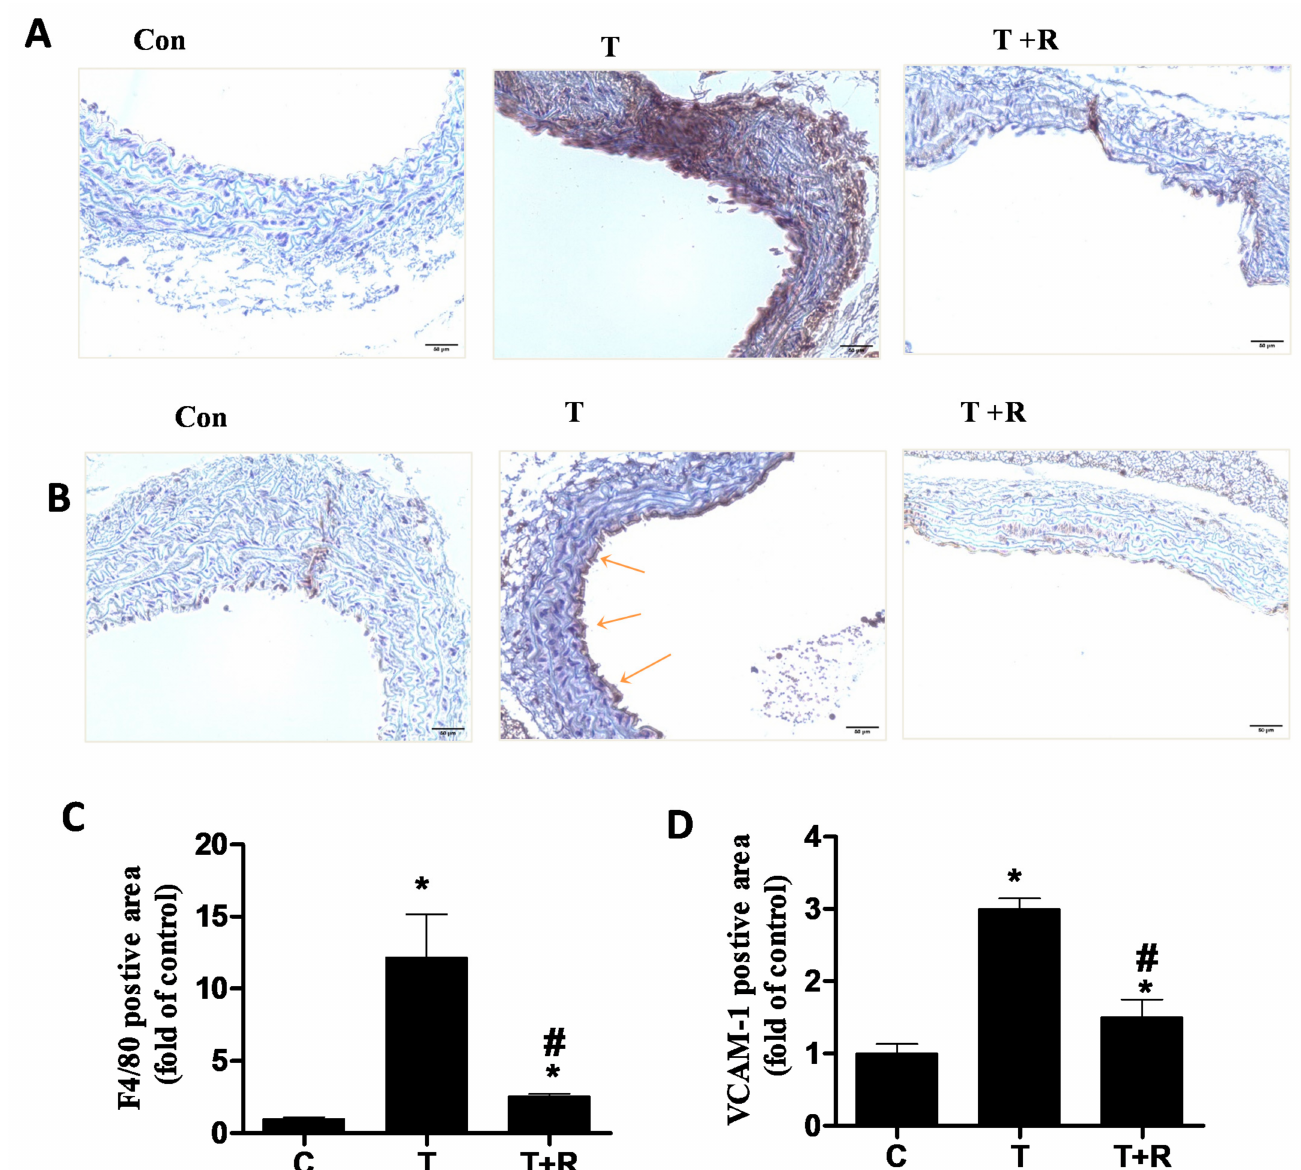
Figure 5. Representative images showing the immunohistochemical staining for F4/80-positive monocyte-derived macrophages ( A ) and adhesion molecule VCAM-1 ( B ) in aortic cross-sections of C57BL/6 mice. C57BL/6 mice were fed AIN-93G rodent diets with and without 0.4% resveratrol for one week followed by 25 µ g/kg/day of TNF- α injected intraperitoneally for 7 days. After the treatment periods, the animals’ aortas were harvested for sectioning. Quantitative analysis of F4/80- ( C ) and VCAM-1- ( D ) positive areas were performed. Arrows indicate typical positive-stained regions at a magnification of 40 × (scale bar = 50 µ m). T, TNF- α ; R, resveratrol; T + R, TNF- α + resveratrol, * p < 0.05 vs. control; #, p < 0.05 vs. TNF- α -alone-treated